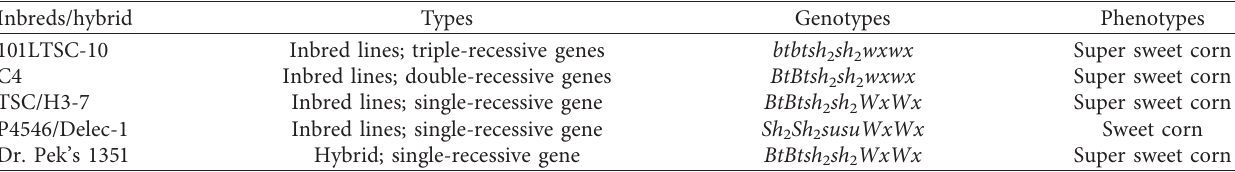
Table 1: Five sweet corn genotypes used in this